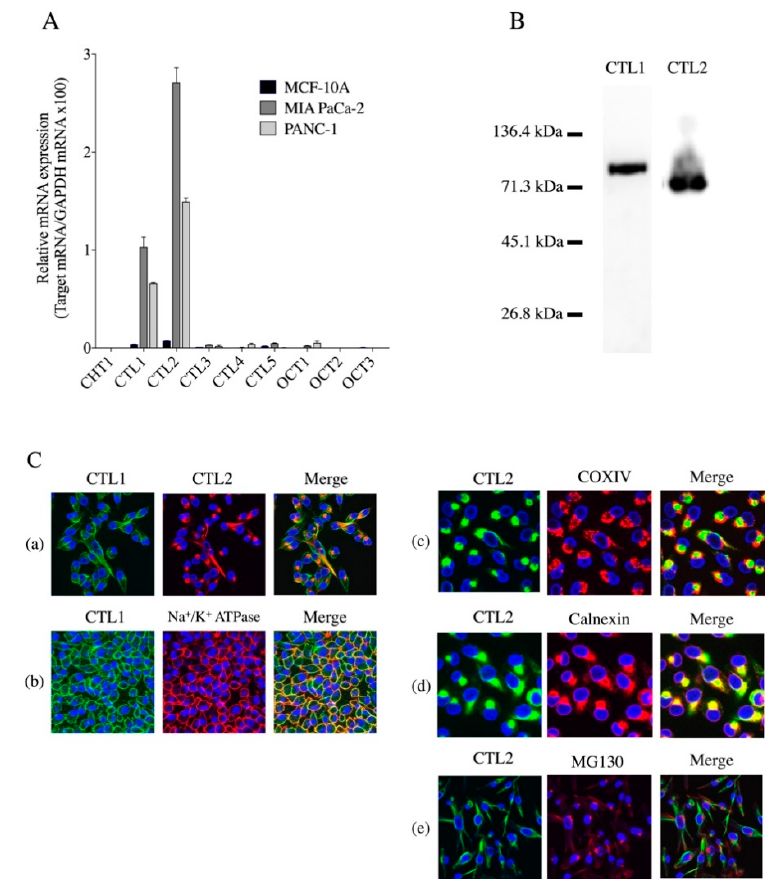
Figure 1. Expression of choline transporters. ( A ) Real-time PCR analysis of mRNA expression of CHT1, CTL1-5, and OCT1,2 in MCF-10A, MIA PaCa-2 and PANC-1 cells ( n = 3). Relative mRNA expression expressed as ratio of target mRNA to glyceraldehyde-3-phosphate dehydrogenase (GAPDH) mRNA, which is a housekeeping gene. ( B ) Expression of CTL1 and CTL2 proteins in MIA PaCa-2 cells by Western blot analysis. ( C ) Intracellular distribution of CTL1 and CTL2 proteins in